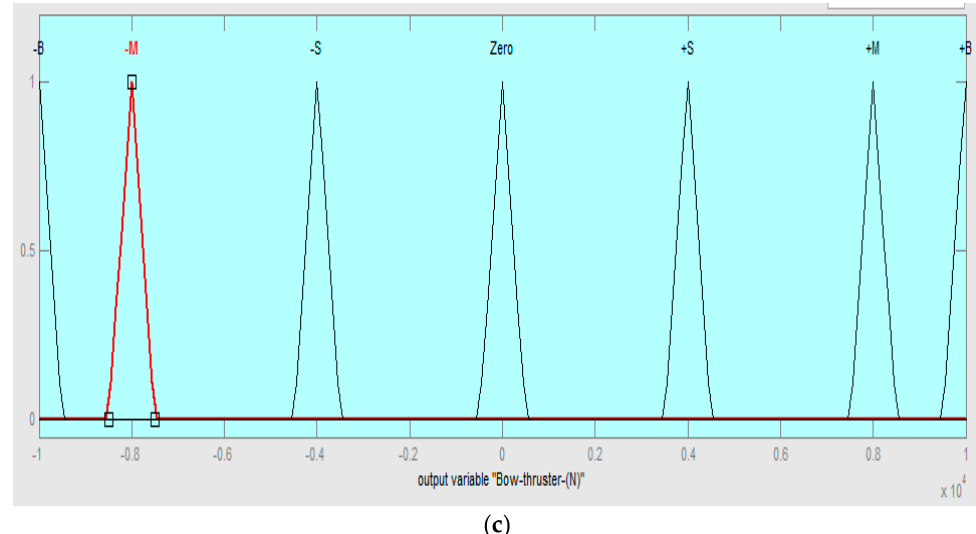
Figure 8. The membership functions of the controller: ( a ) Heading error; ( b ) yaw rate; ( c ) bow thruster. Table 5. The reasoning rules of heading controller.